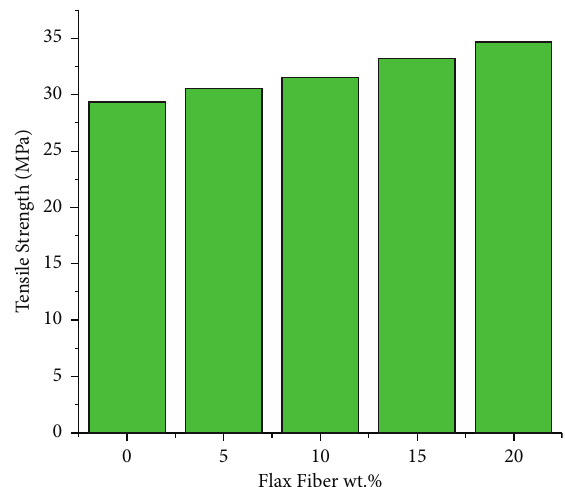
Figure 5: Effect of flax fibre content on tensile strength of pure and hybrid composites.